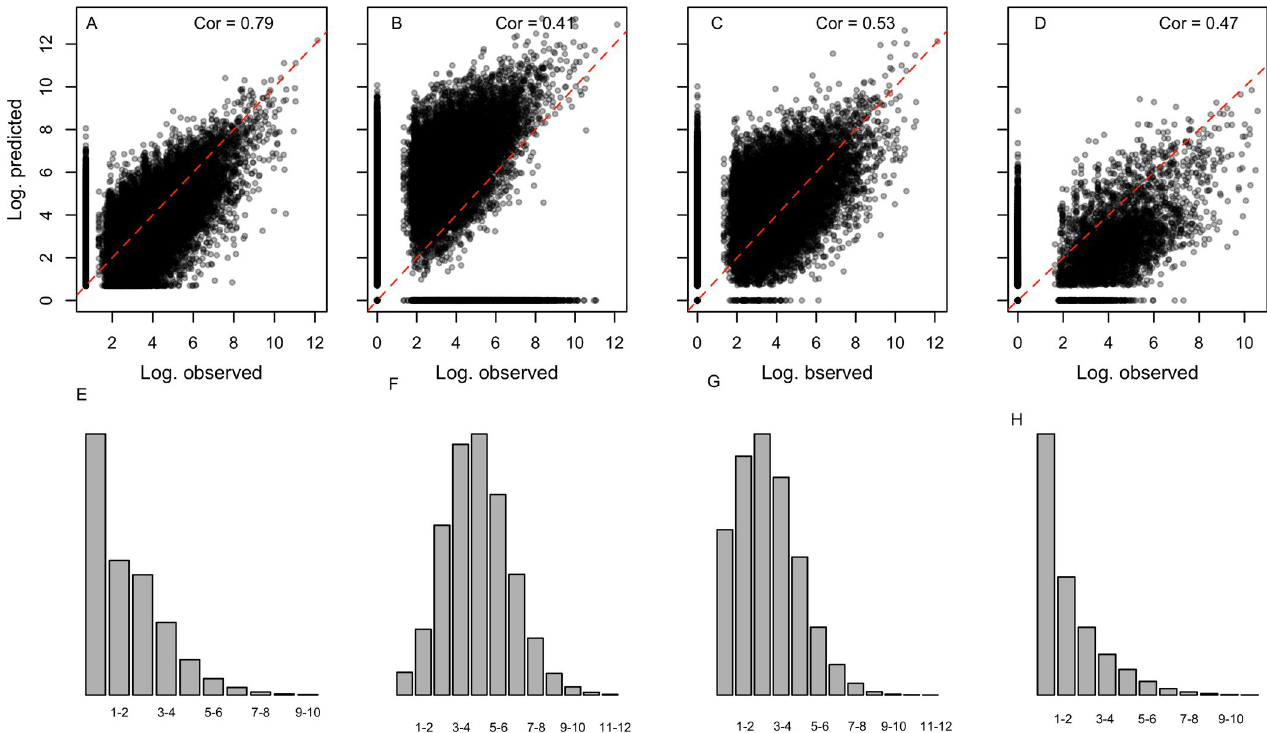
Fig 8. Estimated versus observed migration flows (in log scale) between each pair of intermediate level census units, with estimates based (A) on the intermediate-scale model using the intermediate level migration data, (B) on the broad-scale model by assigning the predicted department level migration proportions to the corresponding single municipalities and multi-municipalities, (C) on the fine-scale model by aggregating the estimated municipality level migration flows to the corresponding intermediate level census units, and (D) on the fine-scale model as in C, but considering only single-municipalities. Red lines represent the identity line, while E through H show histograms of the residuals (in log scale) for the corresponding plots in A-D.